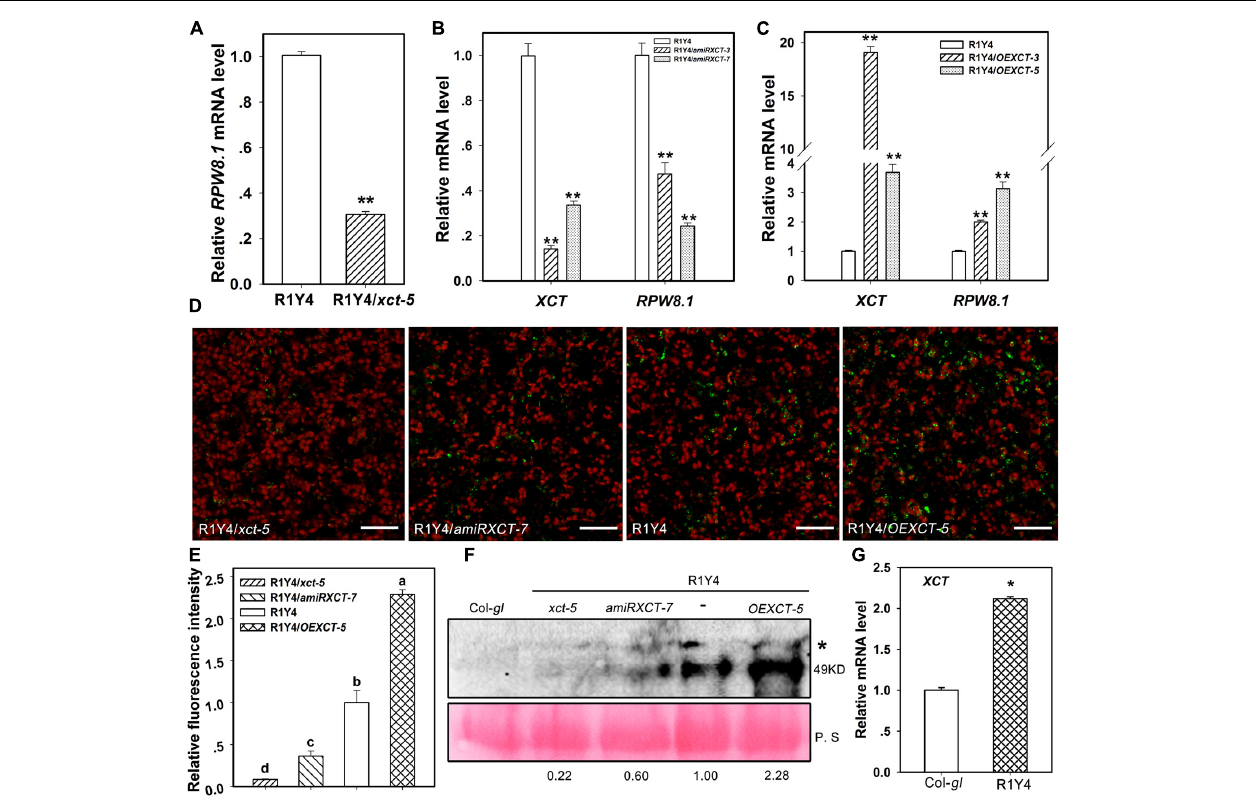
FIGURE 9 | The expression of RPW8.1 and XCT are mutually regulated. (A–C) Expression of RPW8.1 and XCT from the indicated lines examined by qRT-PCR. Transcript levels were normalized to the internal control ACT2 , and the levels in R1Y4 were arbitrarily set as 1.0. Error bars indicate SD ( n = 3). Student’s t- test was performed to determine the significance between R1Y4 and the indicated lines. Asterisks ∗∗ indicate significant differences at P < 0.01. (D) Confocal images show the signal of RPW8.1-YFP fusion protein in the indicated lines at 5-week-old plants. The YFP fluorescence was pseudo-colored green and the auto-fluorescence of chloroplasts was pseudo-colored red. Scale bars, 20 µ m. (E) Quantification analysis on the relative fluorescent intensity of YFP signal from (D) . The average value collected from more than 3 independent plants were processed by Image J. Error bars represent SD ( n = 4). Letters above the bars indicate statistically significant differences ( P < 0.05) by Tukey’s Honestly Significant Difference test. (F) Western blot analysis on the accumulation of RPW8.1-YFP in the indicated lines. RPW8.1-YFP was detected with GFP anti-sera that can also detect YFP. The band at molecular size of ∼ 49 kDa represents RPW8.1-YFP. A non-specific band was also detected ( ∗ ). Rubisco stained by Ponceau S was used as loading control. Values below the Rubisco indicate the relative abundance of RPW8.1-YFP by deducting the difference of loading and normalized to R1Y4 that was arbitrarily set as 1.0. Similar results were obtained in two independent experiments. (G) Relative mRNA level of XCT detected by quantitative RT-PCR from the indicated lines. Asterisk ∗ indicates significant differences at P < 0.01 ( t -test). Similar results were obtained in three independent